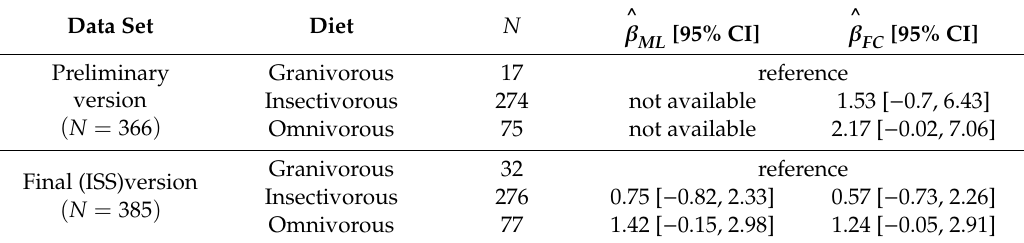
Table 3. Logistic regression coe ffi cient estimates obtained by ML and FC estimation in preliminary and final analyses of the European passerine bird study. All analyses were adjusted for